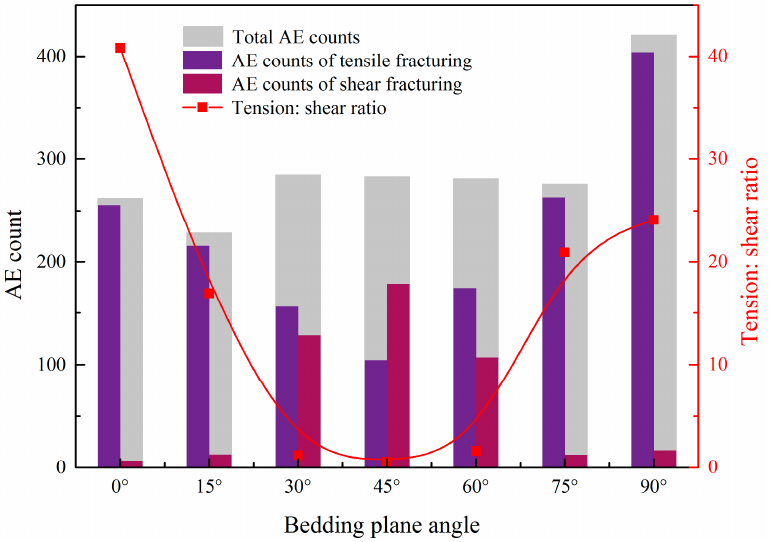
Figure 8. The numbers of AE events and tension: shear ratios. Regularity in the total number of AE events was not obvious. The number of tensile events decreased first and then increased, whereas opposite results were found in terms of the number of shear events. The tension: shear ratio was approximately symmetrically distributed across the seven